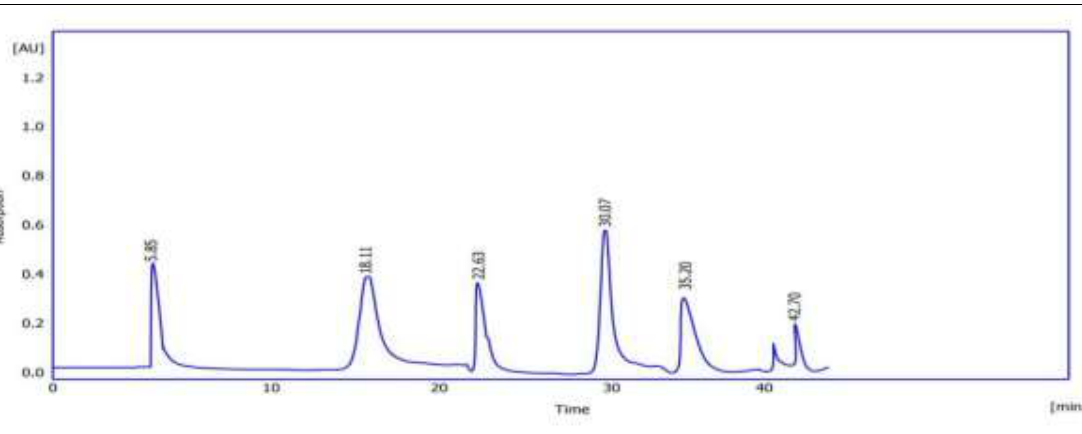
Figure 11. PHPLC chromatogram of petroleum ether fraction of stems that extracted by cold